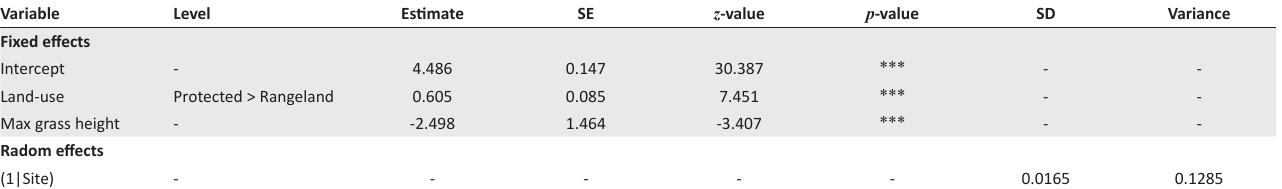
TABLE 2-A1: Results from the generalised linear mixed effects models comparing avian abundances between land-use types (protected areas versus communal rangelands), while taking vegetation structural variables (maximum grass leaf table height and the density of woody vegetation greater than 0.5 meters) into consideration. Variable